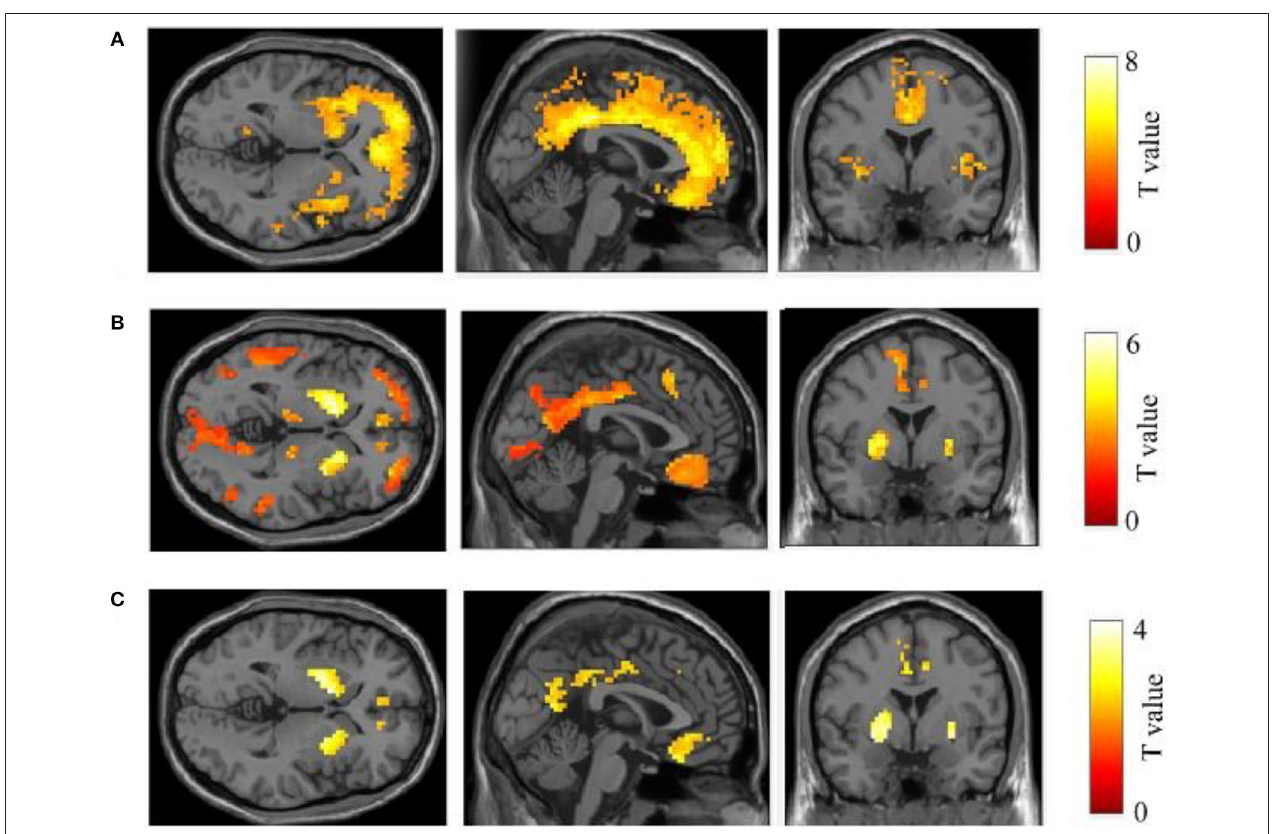
FIGURE 2 | Comparison of 11 C-PIB retention between three groups. In the comparison between LOAD–NC (A) and EOFAD–NC (B) , both AD groups were observed greater 11 C-PIB retention in the cortical and striatal regions. But the caudate, putamen, and amygdala were shown greater 11 C-PIB accumulation in patients with EOFAD than that in patients with LOAD (C) . 11 C-PiB, 11 C-labeled Pittsburgh compound-B; EOFAD, early-onset familial Alzheimer’s disease; LOAD, late-onset Alzheimer’s disease.